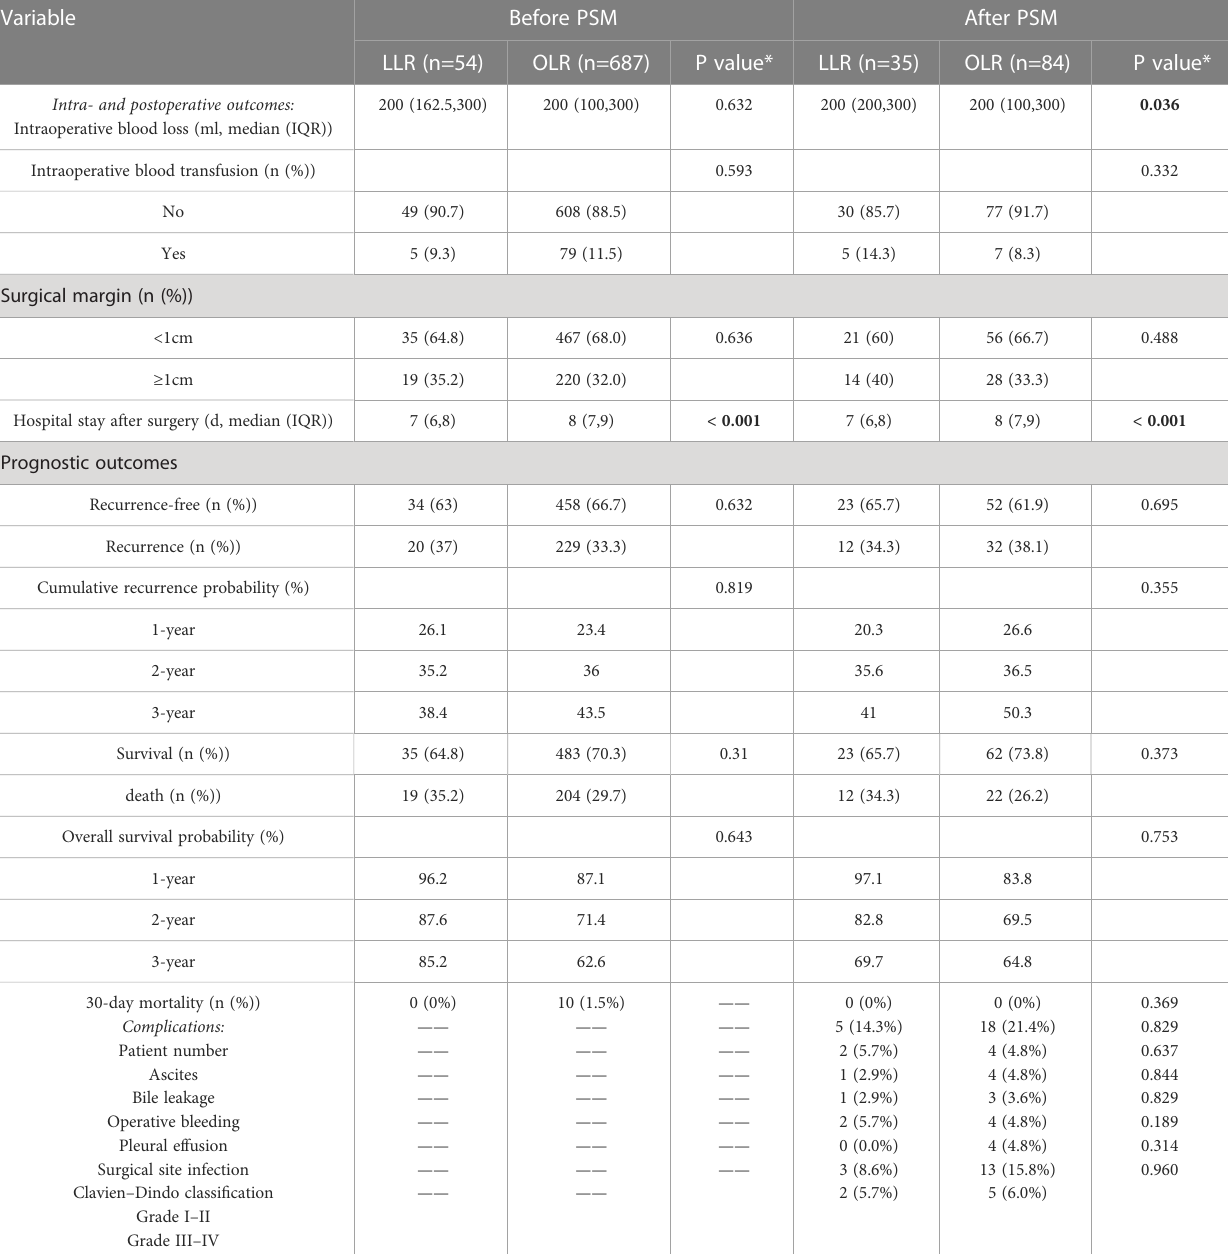
TABLE 2 Characteristics of intra- and postoperative outcomes and postoperative complications of patients before and after propensity score matching. Variable Before